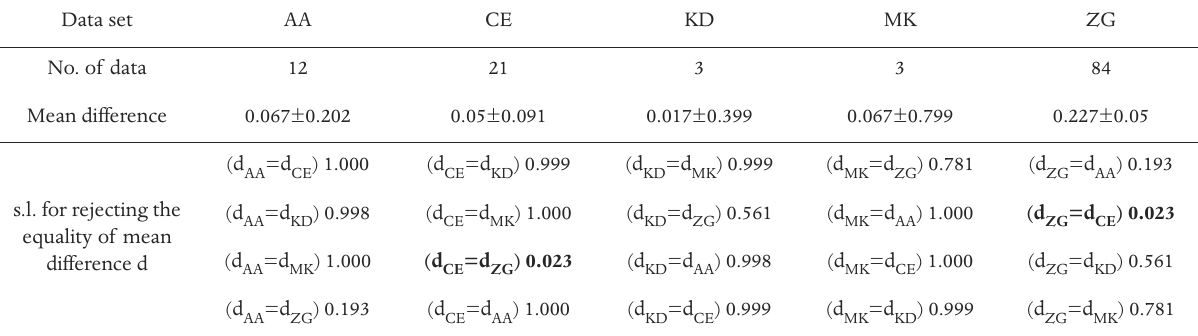
Table 5. As Table 1 for mean differences of the M